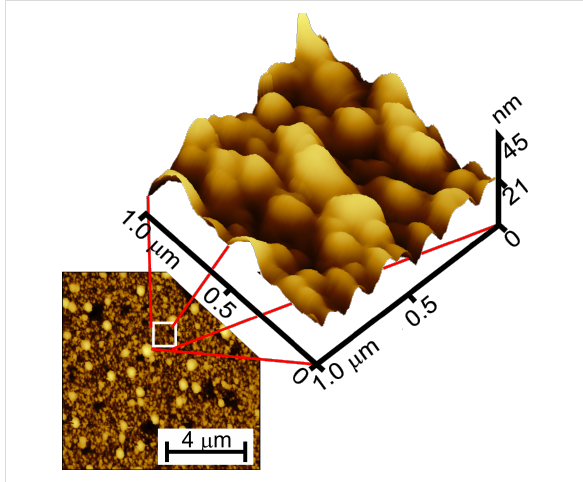
Figure 3: 10 × 10 µm 2 surface scan of SnO 2 nanolayers presented together with 1 × 1 µm 2 magnification. The white square presents the magnified area taken for 1 × 1 µm 2